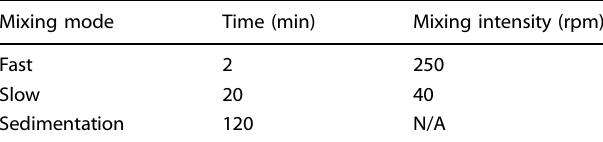
Table 4. Coagulation mixing mode as a simulation of practical